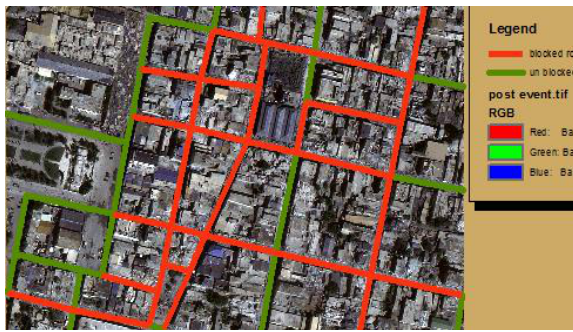
Fig 8. The obtained destruction map from the suggested algorithm